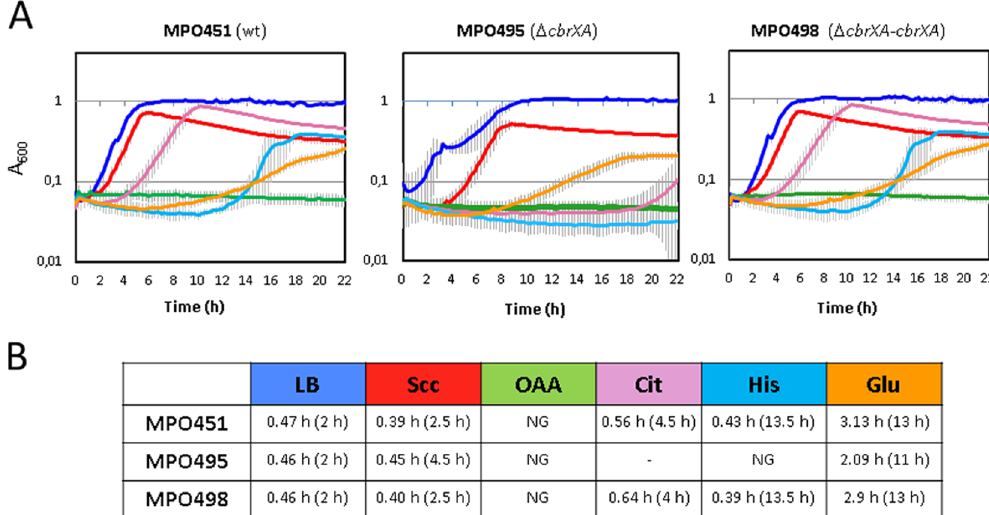
Figure 3. Growth of P. putida wild type, Δ cbrXA mutant and complemented strain in different carbon sources. ( A ) Growth curves of the wild type strain (MPO451), deletion mutant Δ cbrXA (MPO495) and complemented strain (MPO498) in LB and in minimal medium with succinate (Scc, red), oxalacetate (OAA, green), citrate (Cit, pink), histidine (His, cyan) and glucose (Glu, orange) as sole carbon sources. Three biological replicas have been performed for each growth curve but only one representative biological experiment is shown. Error bars represent the standard deviation of the three technical replicates of the same biological experiment. ( B ) Doubling time and lag phase of strains MPO451, MPO495 and MPO498 in rich medium (LB) and M9 medium with succinate (Scc), oxaloacetate (OAA), citrate (Cit), histidine (His) or glucose (Glu) as C sources. Lag phase in each condition is indicated in brackets. NG; no growth, ( − ); growth after 20 hours. Generation time was calculated during the exponential phase of growth as an extrapolation onto an exponential equation.